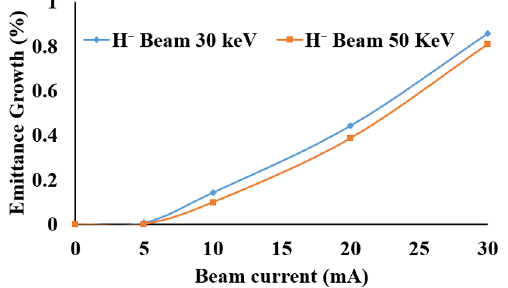
FIG. 4. H − emittance growth vs beam current without com- pensation for a beam with 30 and 50 keV energy in a 0.5 m drift.